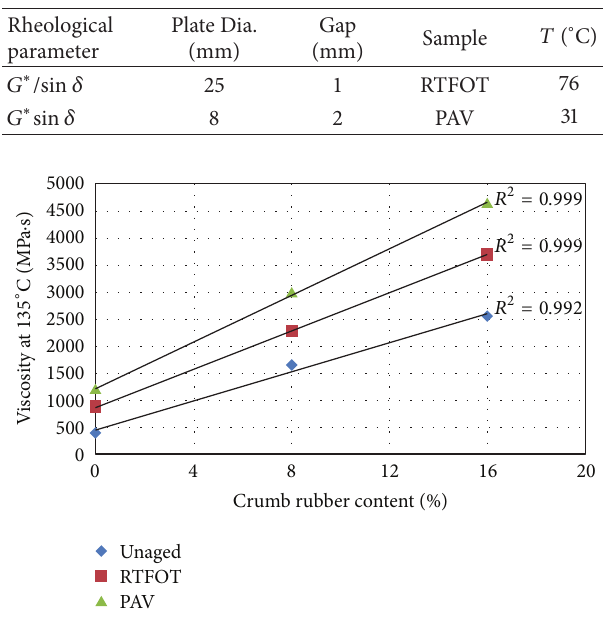
Figure 1: Brookfield viscosity results versus crumb rubber content.